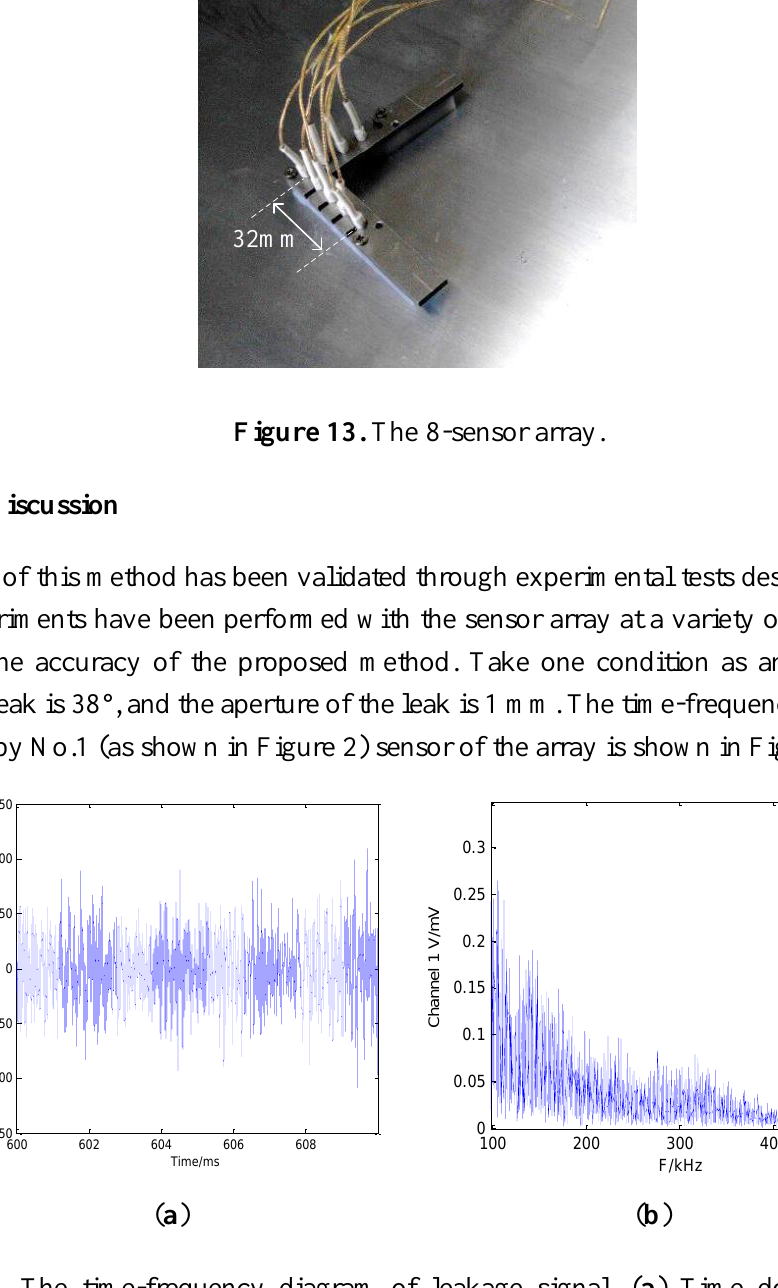
Figure 14. The time-frequency diagram of leakage signal. ( a ) Time domain diagram; ( b ) Frequency domain